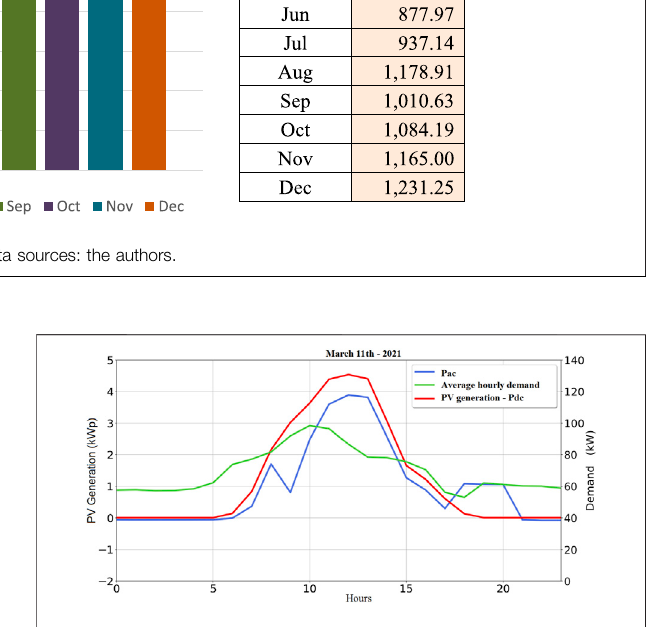
FIGURE 6 | The PV generation pro fi le with maximum hourly irradiation days for the academic weekday - 03/11/2021 versus average hourly demand of March/2019. Data Sources: the